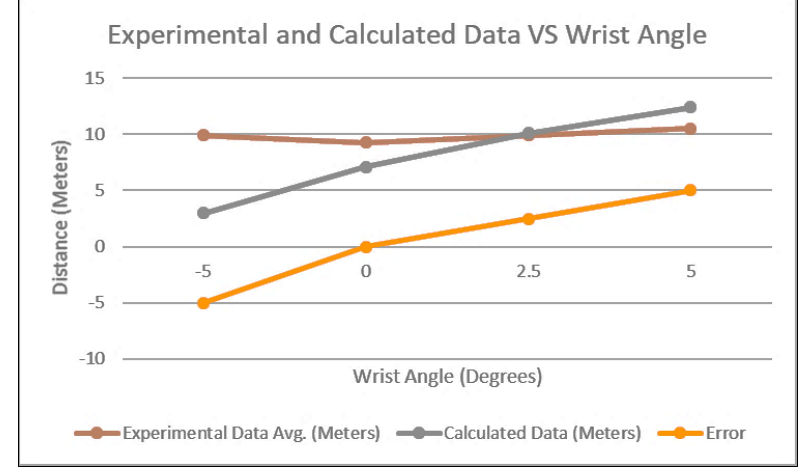
Figure 7. The graph showing a comparison of experimental data and calculated data against Wrist